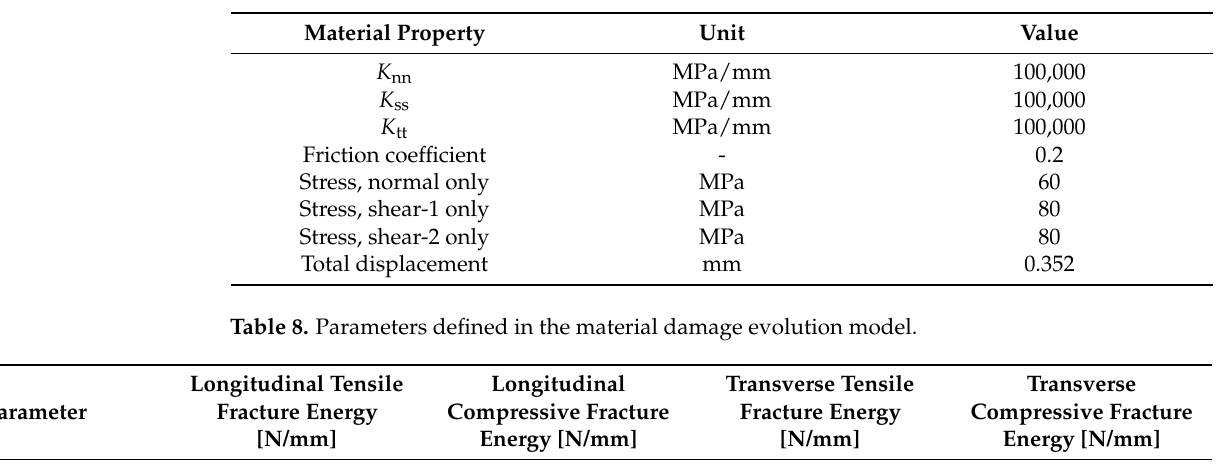
Table 7. Properties of cohesive elements.